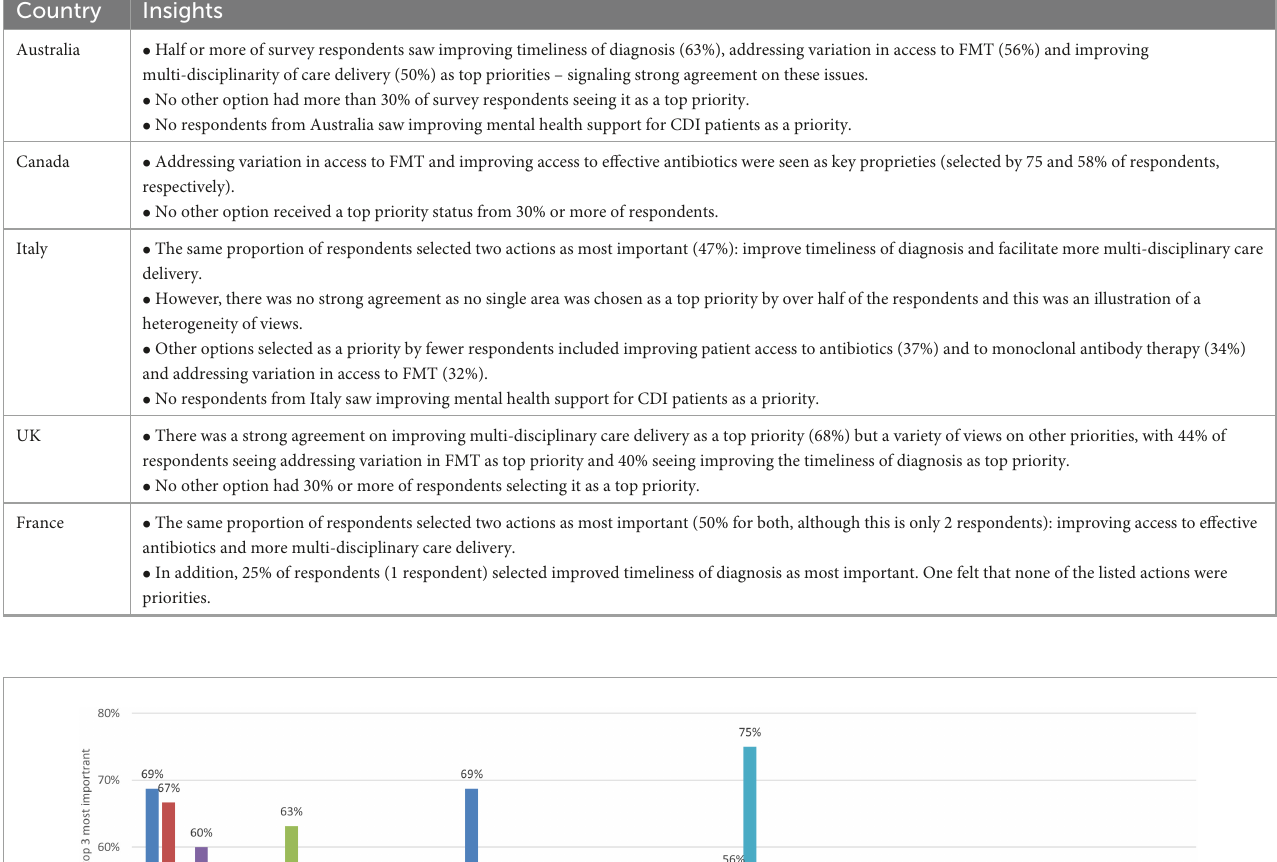
TABLE 5 Country-level insights relating to access and organization of service delivery, and quality of care priorities. Country Insights